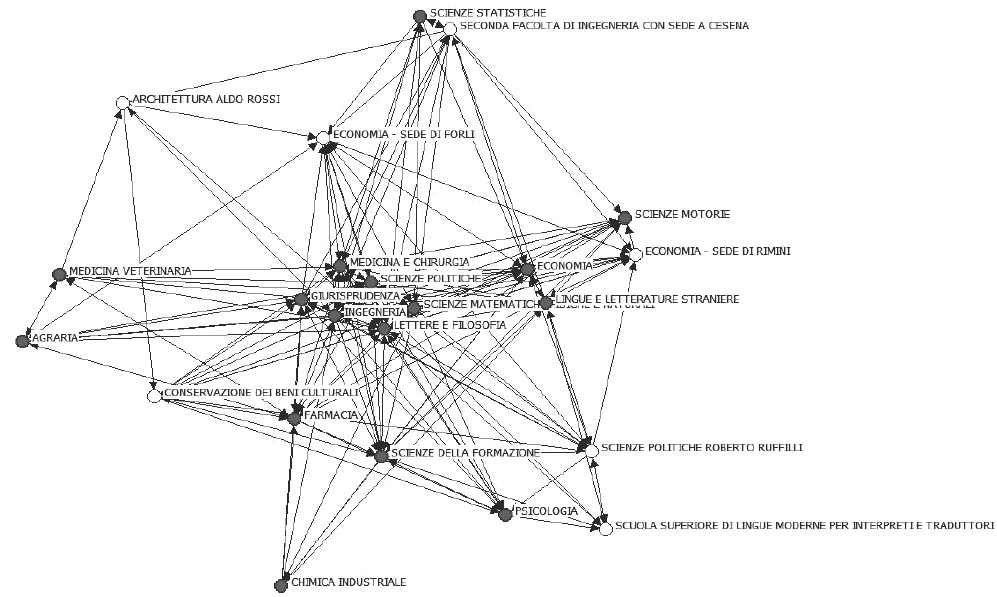
Figure 1 – MDS of Geodesic